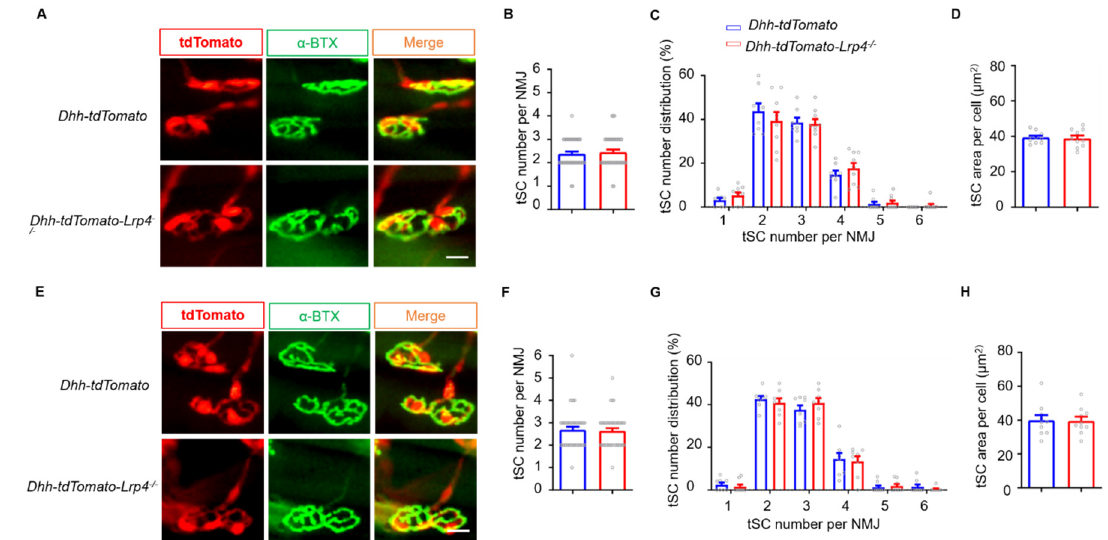
Figure 4. tSCs are not involved in accelerating regeneration in Lrp4 cKO mice. ( A ) Representative images of tSCs in Dhh-tdTomato and Dhh-tdTomato-Lrp4 -/- mice at 7 dpc. Scale bar = 25 μ m. ( B ) The number of tSCs per NMJ in the soleus muscle at 7 dpc. Control and cKO, n = 42 NMJs, 3 mice/group. ( C ) Distribution of the different tSC numbers in the NMJs of the soleus muscle at 7 dpc. Control and cKO, n = 8 slices. ( D ) The average area of the tSC in the soleus muscle at 7 dpc. Control and cKO, n = 10 cells. ( E ) Representative images of tSCs in Dhh-tdTomato and Dhh-tdTomato-Lrp4 -/- mice under normal conditions. Scale bar = 25 μ m. ( F ) The number of tSCs per NMJ in the soleus muscle. Control and cKO, n = 42 NMJs, 3 mice/group. ( G ) Distribution of the different tSC numbers in the NMJs of the soleus muscle. Control, n = 8 slices; cKO, n = 9 slices. ( H ) The average area of the tSC per NMJ in the soleus muscle. Control and cKO, n = 10 cells. All the data are presented as the mean ± SEM.